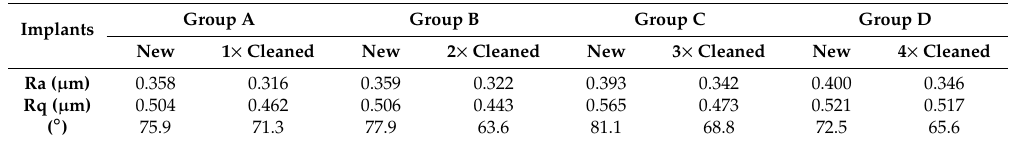
Table 1. Arithmetical mean roughness Ra and root mean square Rq values for all groups of new as well as cleaned samples. Wettability is expressed in the form of the angle between the tangent of the drop and the horizontal baseline of the solid surface.